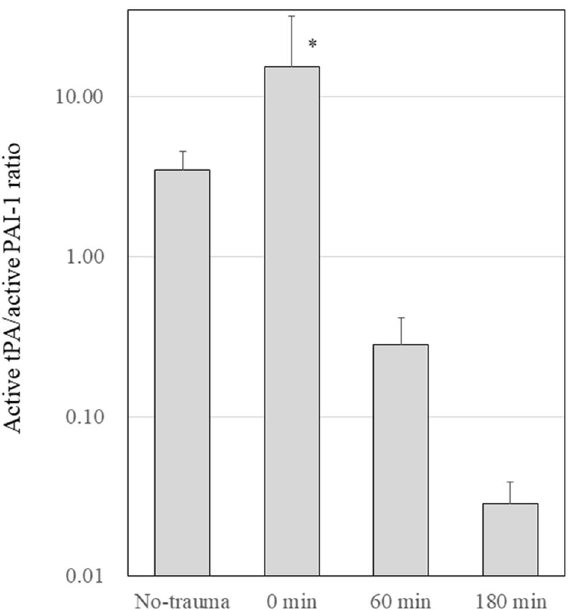
Figure 3. Balance between activation and suppression of the fibrinolytic system. Active tPA and active PAI-1 ratios are presented. Although the balance tipped toward fibrinolytic activation immediately after trauma, the balance tipped toward fibrinolytic suppression at 60 and 180 min ( P < 0.001, one-way ANOVA). tPA, tissue-plasminogen activator; PAI-1, plasminogen activator inhibitor-1. * P < 0.05 using Dunnett’s test for the no-trauma